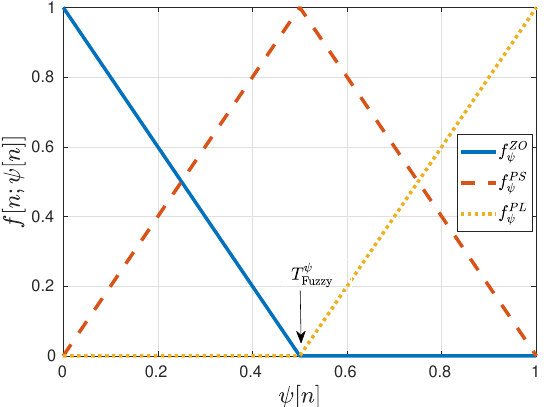
Table 1. Structure of the fuzzy Matrix W fuzzy